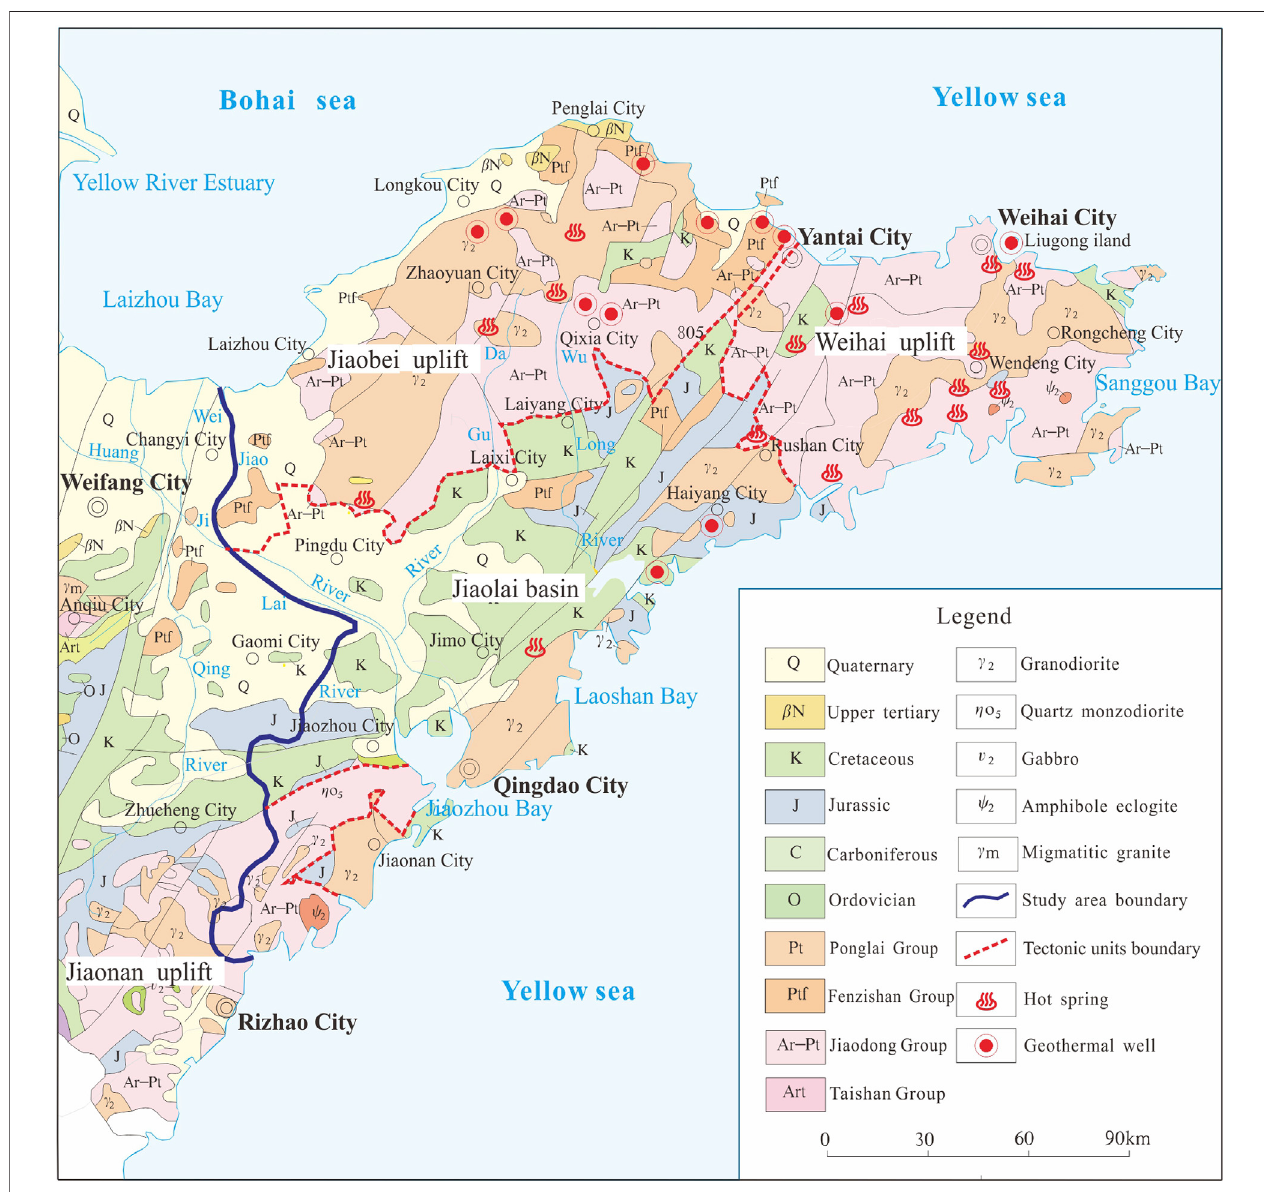
FIGURE 2 | Regional geological map of the Jiaodong